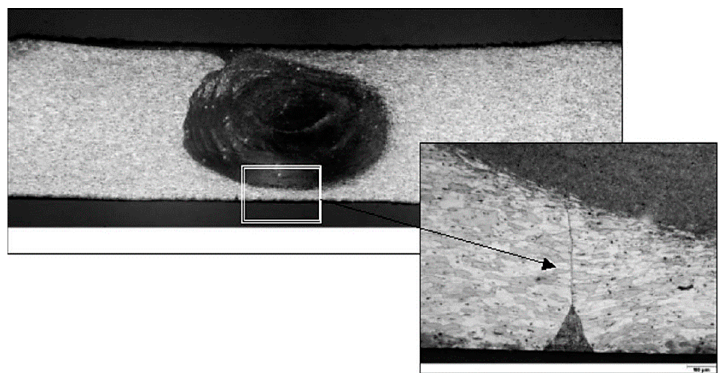
Figure 24. FSW lack of penetration defect [61]. The bar scale in the inset is 50 micrometers. Reprinted from: On the fatigue behavior and design curves of friction stir butt-welded Al alloys. International Journal of Fatigue 27, no. 3 (2005): 305–316, Lomolino, S., R. Tovo, and J. Dos Santos, Copyright 2005, with permission from Elsevier.